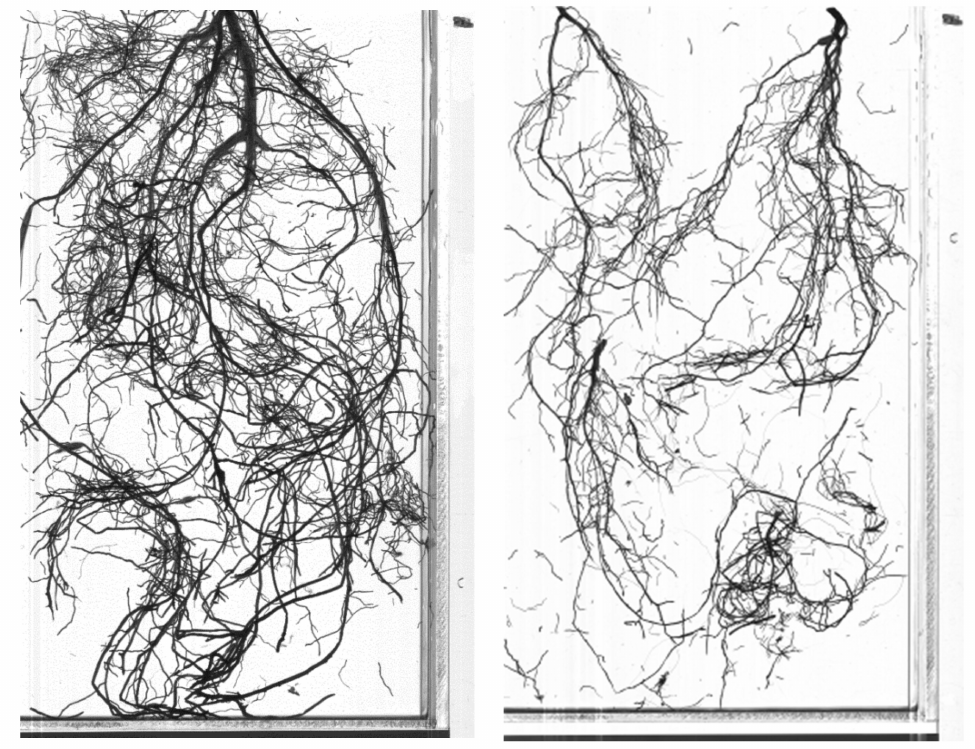
Figure 3. ( Left ) Scanned image of un-sprayed tedera control; ( Right ) tedera sprayed with bromoxynil + diflufenican at 250 + 25